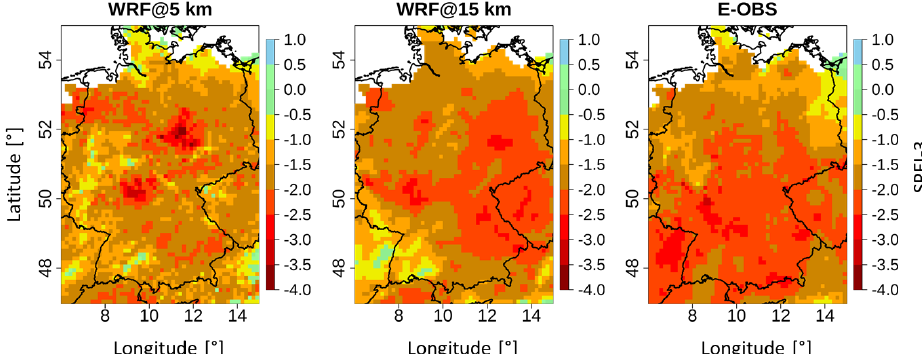
Figure 3. SPEI-3 values for August 2003 from the two WRF domains and E-OBS.